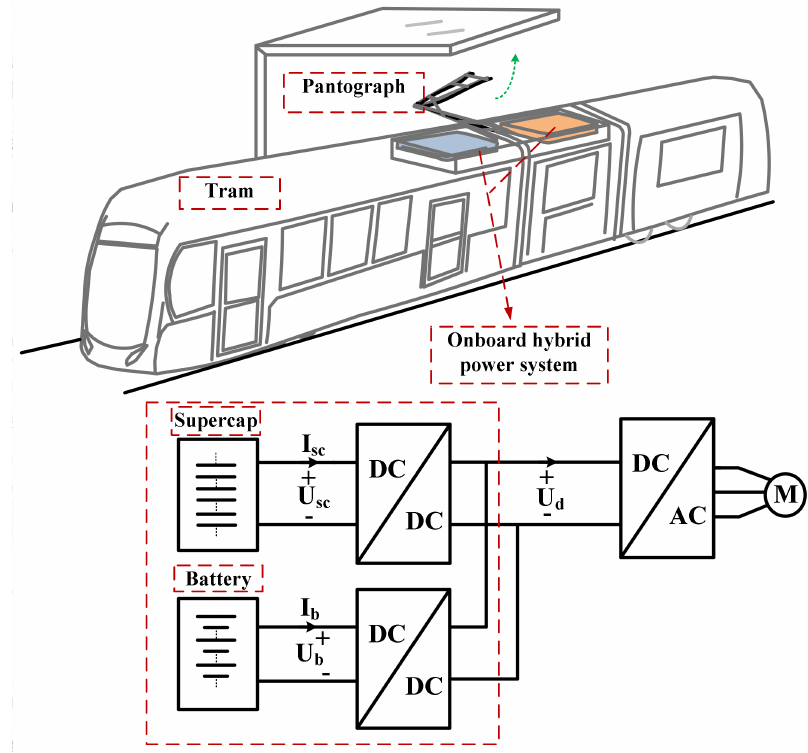
Figure 3. Topology of the hybrid energy storage